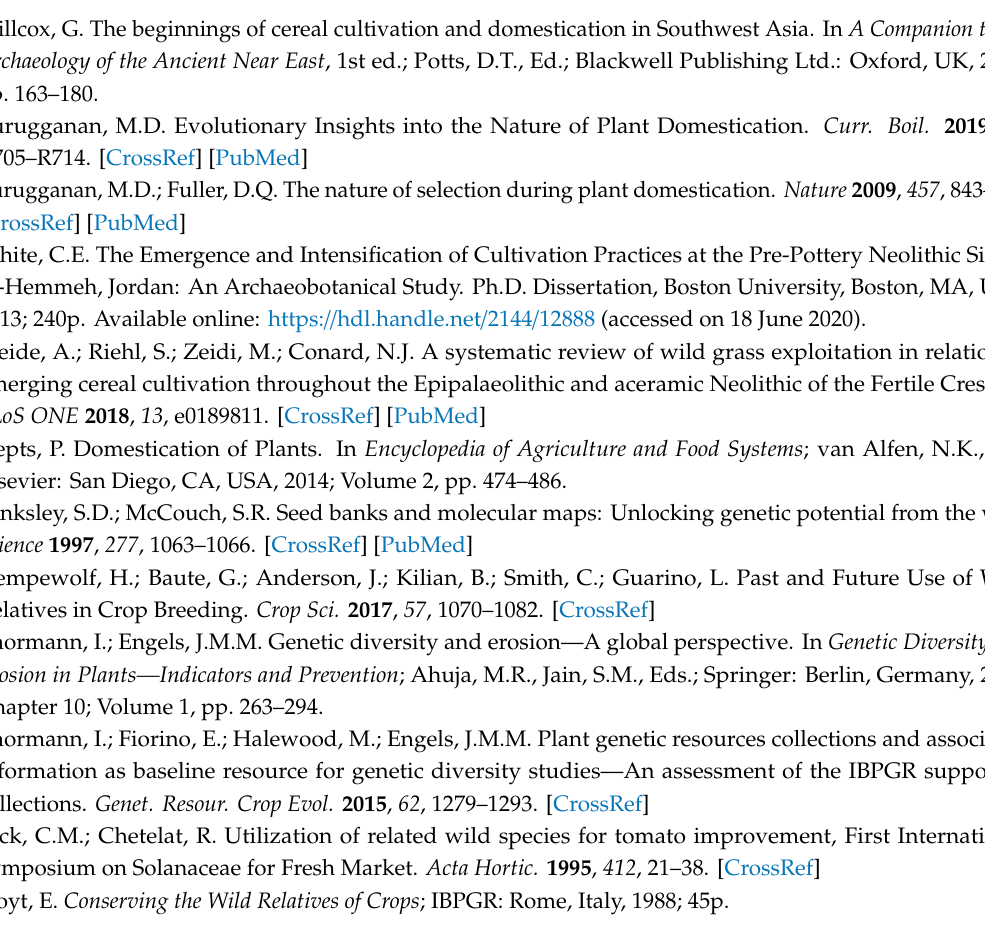
Table S1: Guidelines and tools for CWR conservation, including references